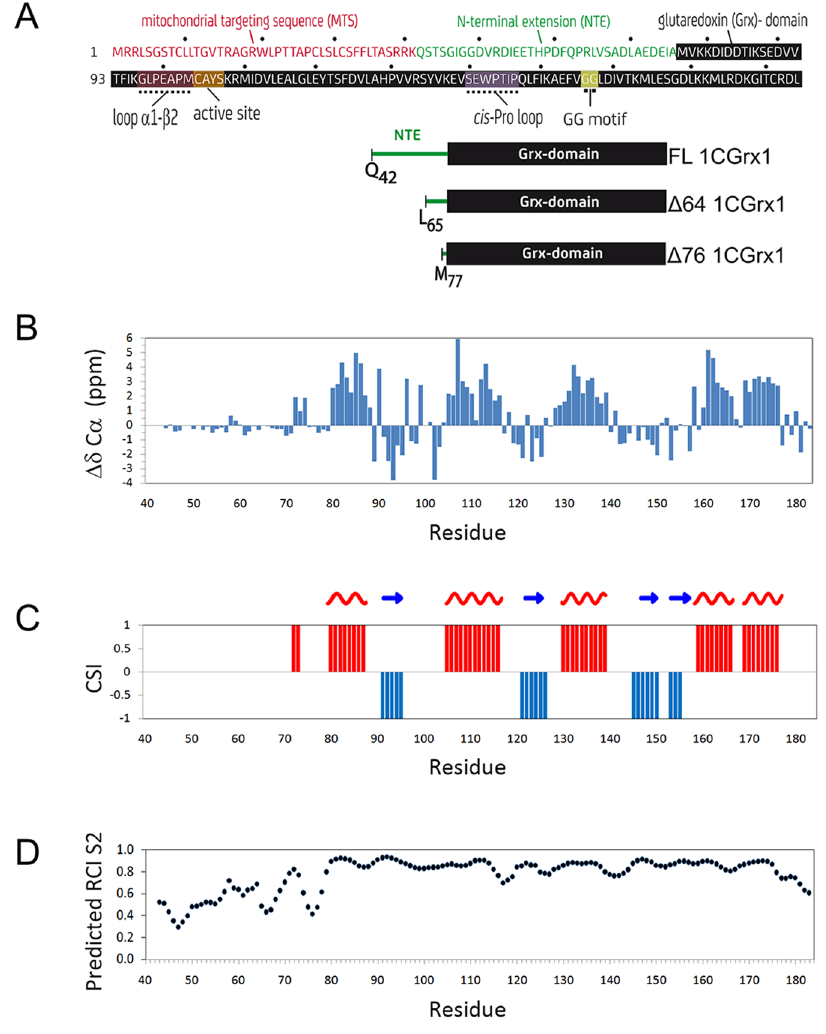
Figure 1. In panel ( A ), the sequence and functional or structural elements/motifs of 1CGrx1 are shown. MTS: mitochondrial targeting sequence, NTE: N-terminal extension and Grx: glutaredoxin-domain. The three forms of 1CGrx1 addressed in this manuscript are schematized and labelled with the corresponding nomenclature: FL 1CGrx1 (residues 42–184); Δ 64 1CGrx1 (residues 65–184); Δ 76 1CGrx1 (residues 77–184). The additional N-terminal GAMG or GA residues added to FL or Δ 76 1CGrx1 respectively, as a consequence of the cloning strategy (see Materials and Methods) are not shown here. In panel ( B–D ), the structural properties of FL 1CGrx1 derived from backbone chemical shift, as a function of residues number are reported ( B ), secondary C α chemical shift ( Δδ C α ) ( C ), secondary structure elements predicted using the chemical shift index (CSI) approach: red and blue bars represent α -helix and β -strand respectively ( D ), protein flexibility from the model- free order parameter (S 2 ) estimated calculating the Random Coil Index (RCI) from backbone chemical